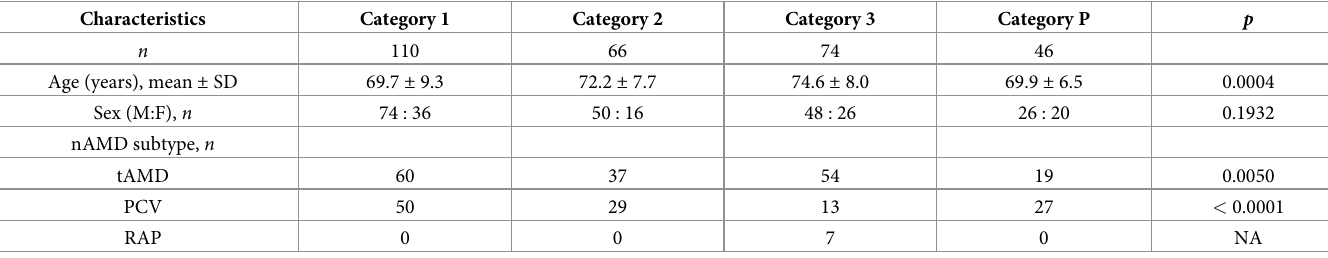
Table 1. Clinical characteristics of the enrolled unilateral nAMD patients and categorization in the fellow eyes. Characteristics